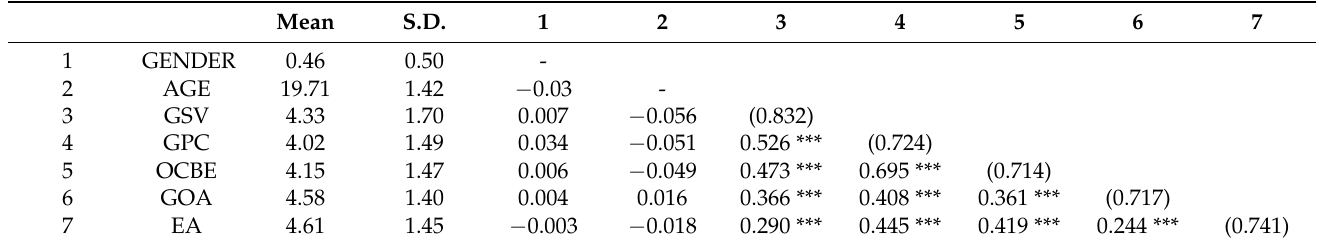
Table 1. Means, standard deviations, reliabilities, and correlations among study variables.